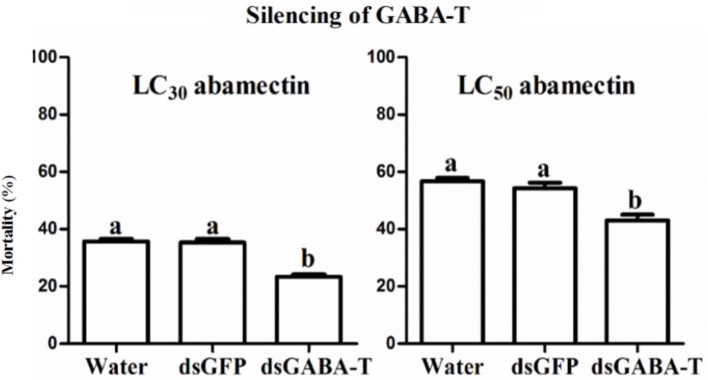
The corrected mortality of SS mites when treated with LC30 and LC50 of abamectin after RNAi. The significant difference (P < 0.05) was indicated by letters.